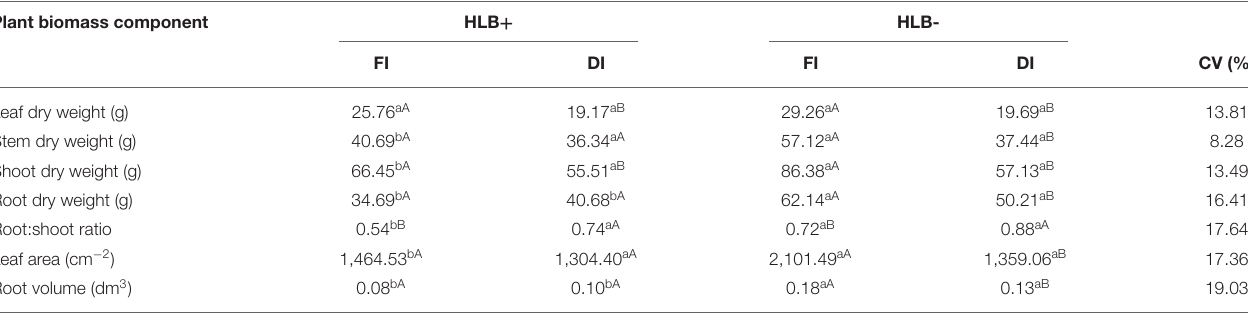
TABLE 1 | Leaf area, root volume and leaf, stem shoot and root dry weights of “Valência” orange trees [ Citrus sinensis (L.) Osbeck] grafted on citrumelo “Swingle” rootstock [ Citrus paradisi Macfad. x Poncirus trifoliata (L.) Raf.] either infected with “ Ca . Liberibacter asiaticus”. Plant biomass component HLB